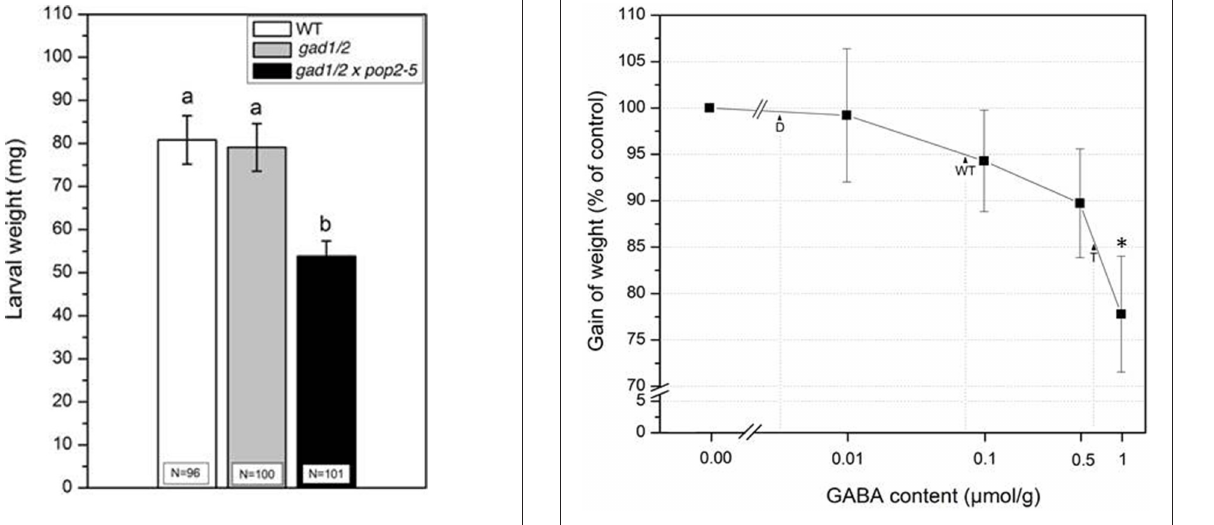
FIGURE 4 | Effects of GABA on S. littoralis g rowth. Mean ( ± SE, n = 18 –20) gain of weight of 2nd instar S. littoralis larvae feeding on artificial diet containing 0, 0.01, 0.1, 0.5, and 1 µ mol GABA /g − 1 . Larval weight was determined after 7 days of feeding and the increase in weight correlated with the starting weight. Gain of weight was calculated relative to the weight gained after control treatment without GABA ( = 100%). Statistically significant differences between the control and the respective treatment was analyzed by t -test (for each concentration separately), * P = < 0.05. D double mutant ( gad1/2 ), WT wild type, T triple mutant ( gad1/2 x pop2-5